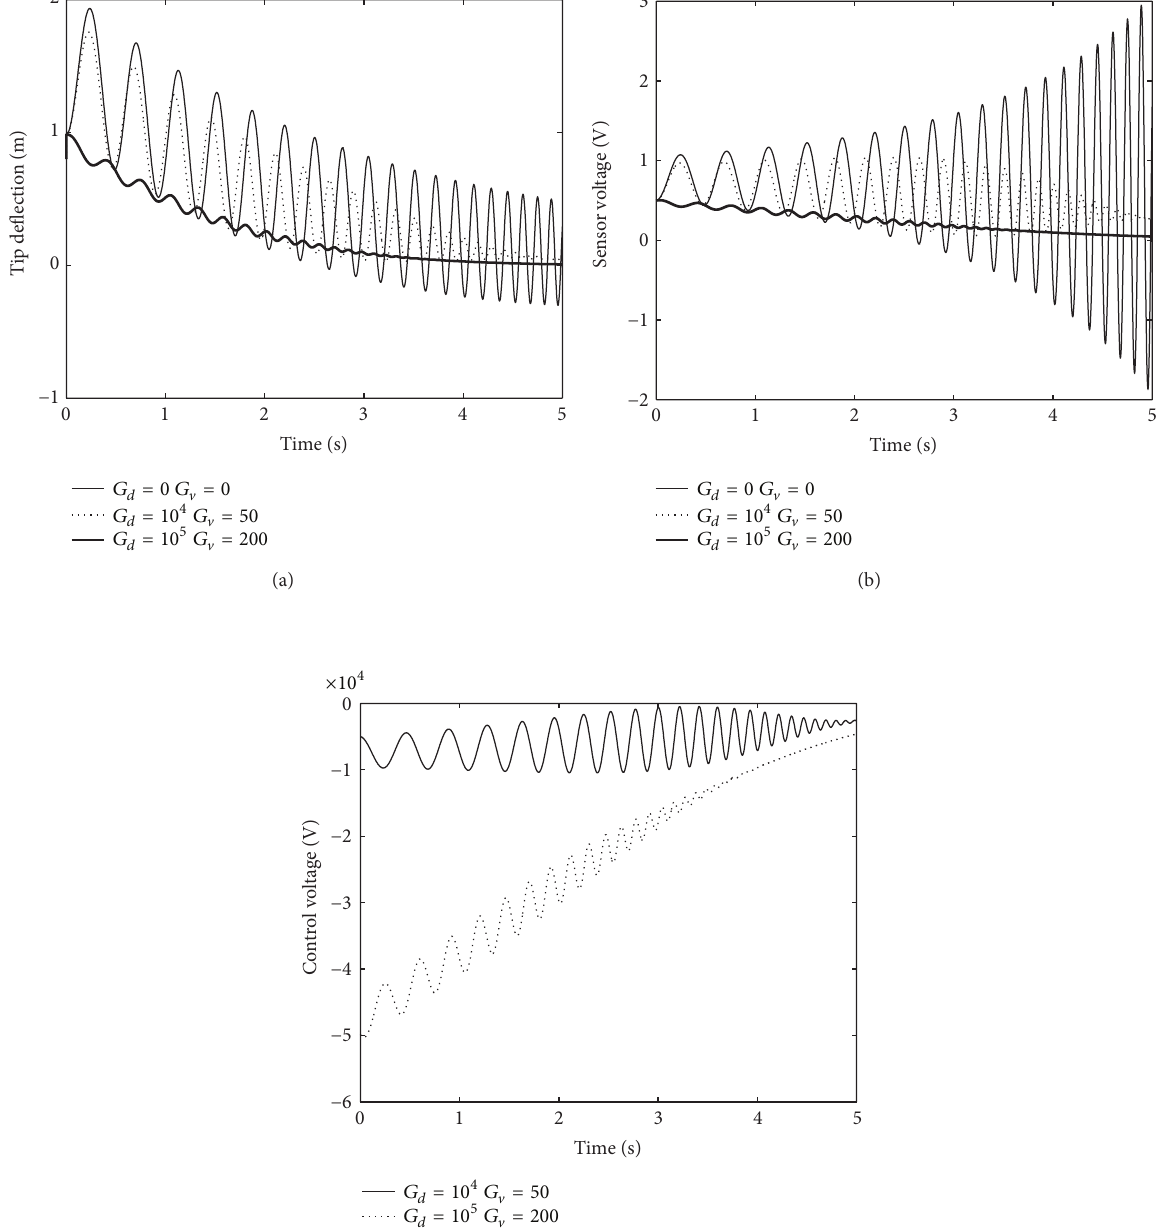
Figure 7: Tip deflection (a), sensor voltage, (b) and control voltage (c) of the arm under different control gain when 𝐿(𝑡) = 2 − 0.2𝑡 , 0.2𝜋